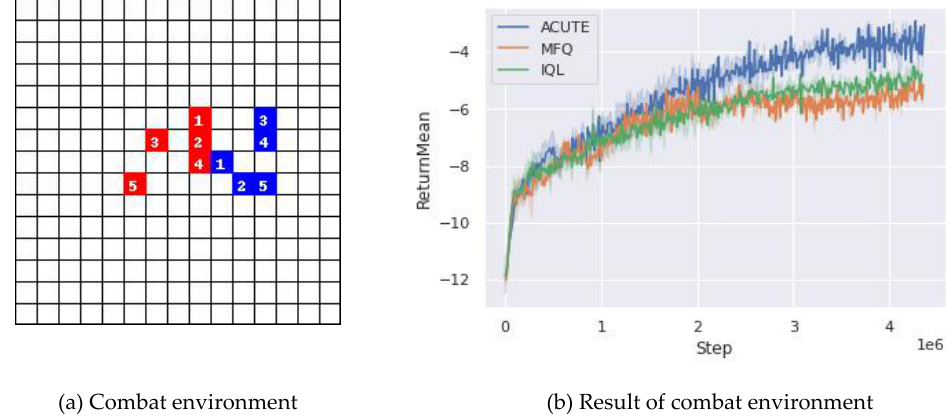
Figure 2. Sample and experiment results in ma-gym: Combat.